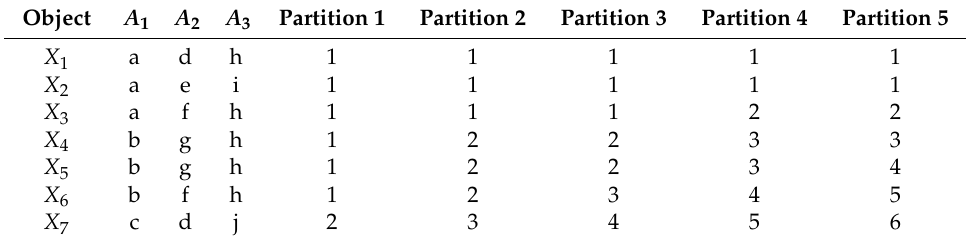
Table 2. Example of a dataset with five partitions. The number of clusters is 2, 3, 4, 5, and 6, respectively.